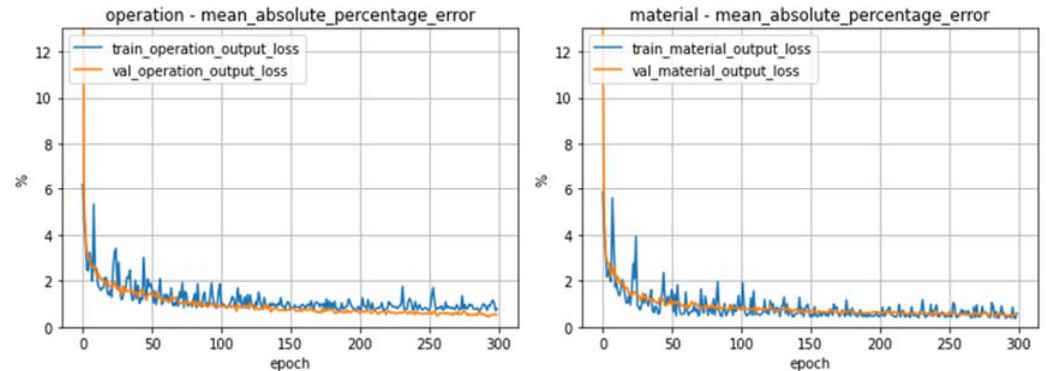
Figure 14. The plots visualize the Neural Network training process. It can be observed that the output for Material (Embodied Carbon) converges much faster. The Loss function value for Embodied Carbon almost stops improving after epoch 100. On the other hand, the output for Operation Carbon Footprint improves its Loss function value until the last epoch.